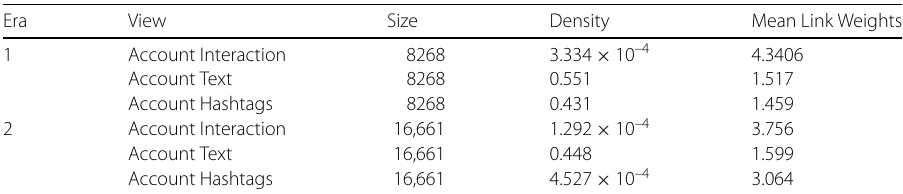
Table 3 Descriptive statistics for unimodal representations of each network view across time periods analyzed